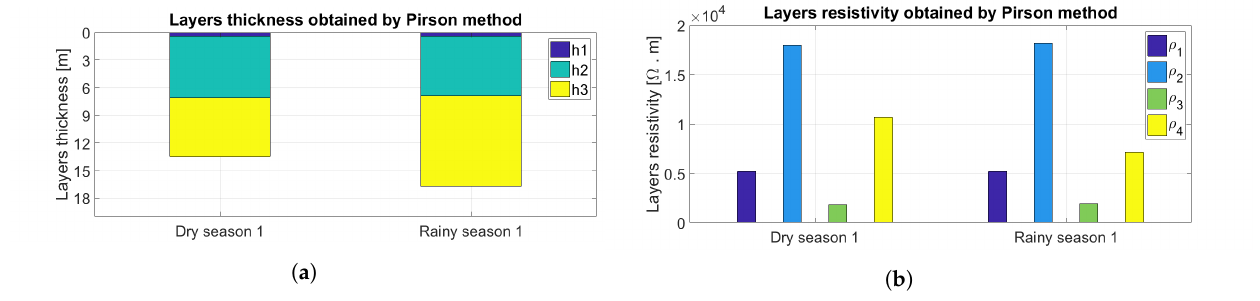
Figure 12. Soil stratification using the Pirson method: ( a ) layers thickness and ( b ) layers resistivity. As in Pirson’s method N is imposed, N = 3 is considered for both analyzed periods.